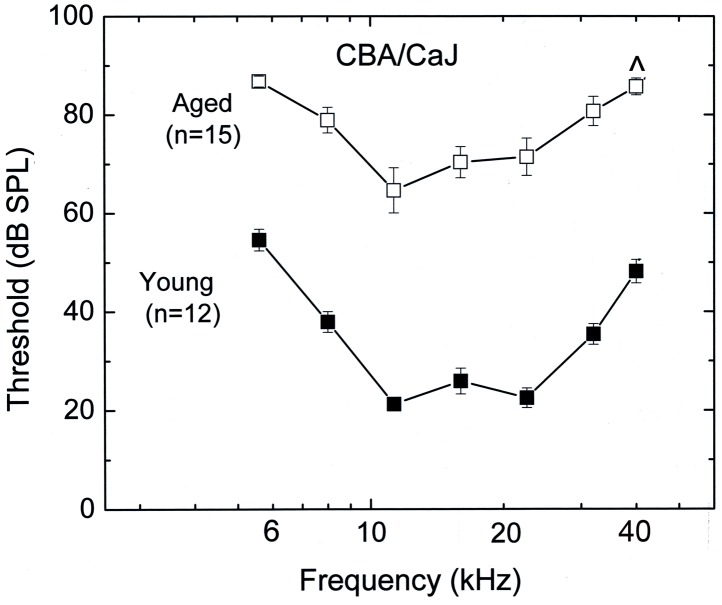
Auditory function declines with age in CBA/CaJ mice.ABR thresholds increased in aged mice at all tested frequencies. Mean ABR thresholds differed significantly between young adult (1–3 month-old) and aged (2–2.5 year-old) CBA/CaJ mice (mean ± SEM, p<0.05). Eight of the 15 aged mice (∧) showed no response to stimuli at 40 kHz.